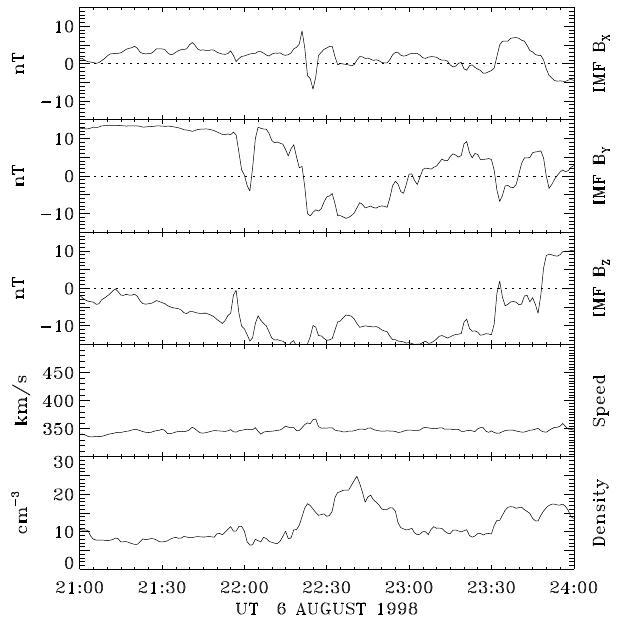
Fig. 1. Solar wind data from WIND propagated to 12 R E . A time lag of 22 min has been applied. Panels 1–3: X , Y and Z GSM components of the interplanetary magnetic field. Panel 4: Solar wind bulk speed. Panel 5: Solar wind ion density. The spacecraft was located at (91, 11, − 3 R E